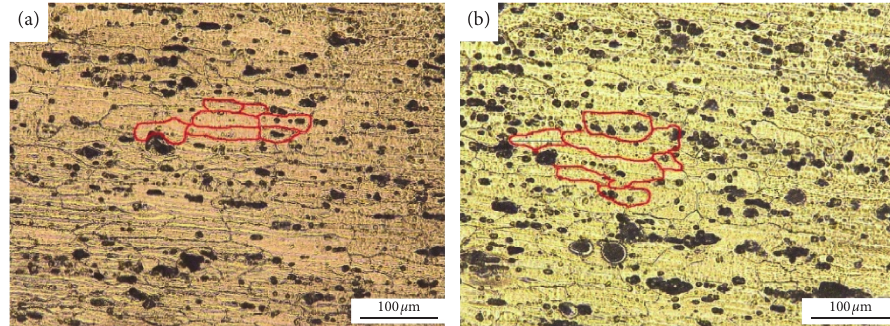
Figure 3: Microstructure of (a) BM and (b) HAZ in WJ.